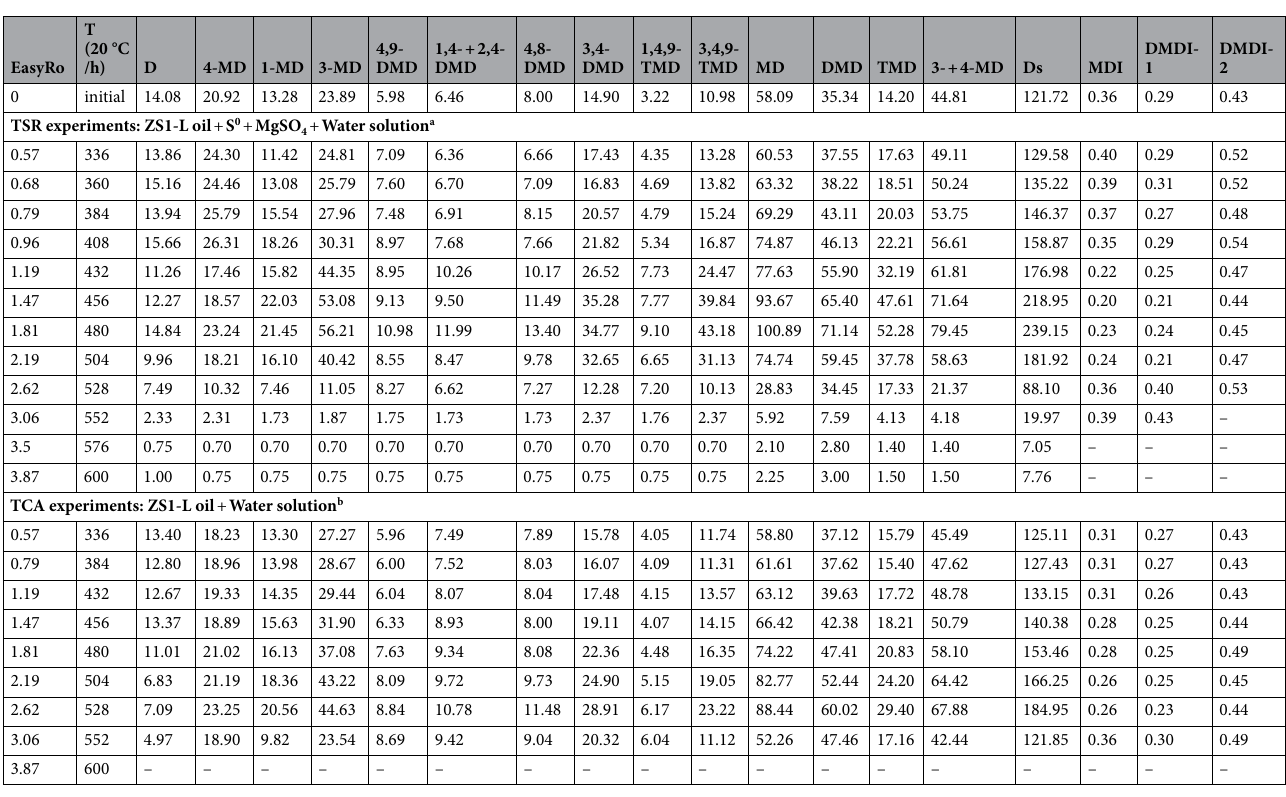
Table 3. The yields (µg/g oil) of individual diamantane compounds identified in Table 1 at each heating temperature of TSR experiments (Group1) and TCA experiments. –indicates not detected. a Water solution containing: 5.6 wt.% MgCl 2 , 10 wt.% NaCl and 0.56 wt.% MgSO 4 . b Water solution containing: 5.6 wt.% MgCl 2 , 10 wt.%